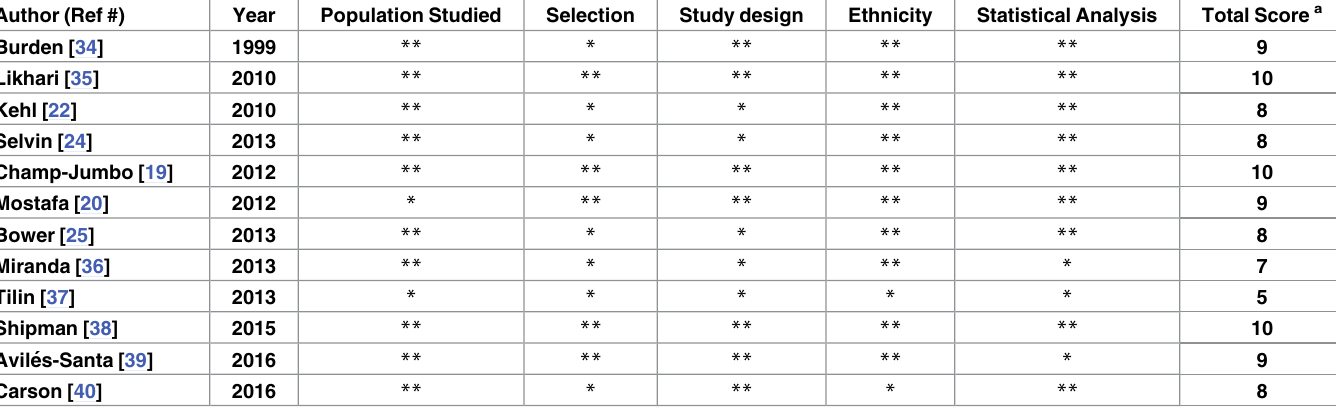
Table 2. Adapted Newcastle-Ottawa quality assessment scale for the studies included in the meta-analysis.